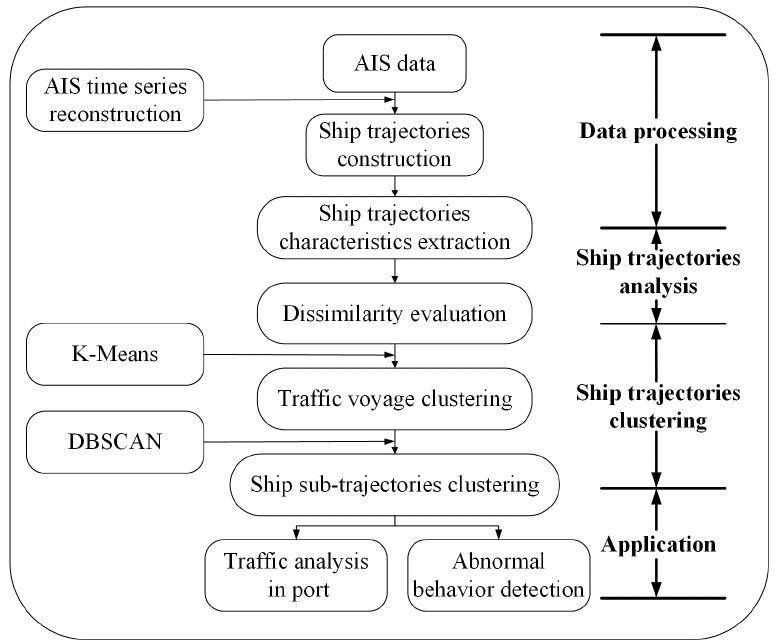
Figure 2. The flowchart for ship trajectory clustering and anomaly detection based on hybrid-clustering model.